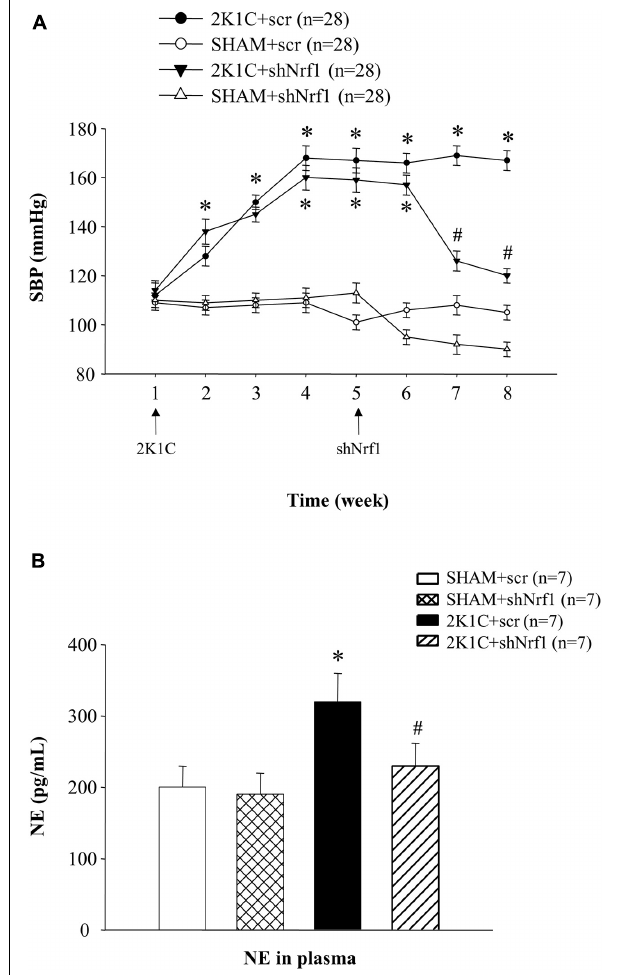
FIGURE 1 | Results of blood pressure and plasma NE in different groups. (A) Effects of knocking down Nrf1 on SBP of hypertensive rats. ∗ P < 0.05 vs. control animals (SHAM + scr or SHAM + shNrf1). # P < 0.05 2K1C + shNrf1 vs. 2K1C + scr. (B) Effects of knocking down Nrf1 on NE in hypertensive